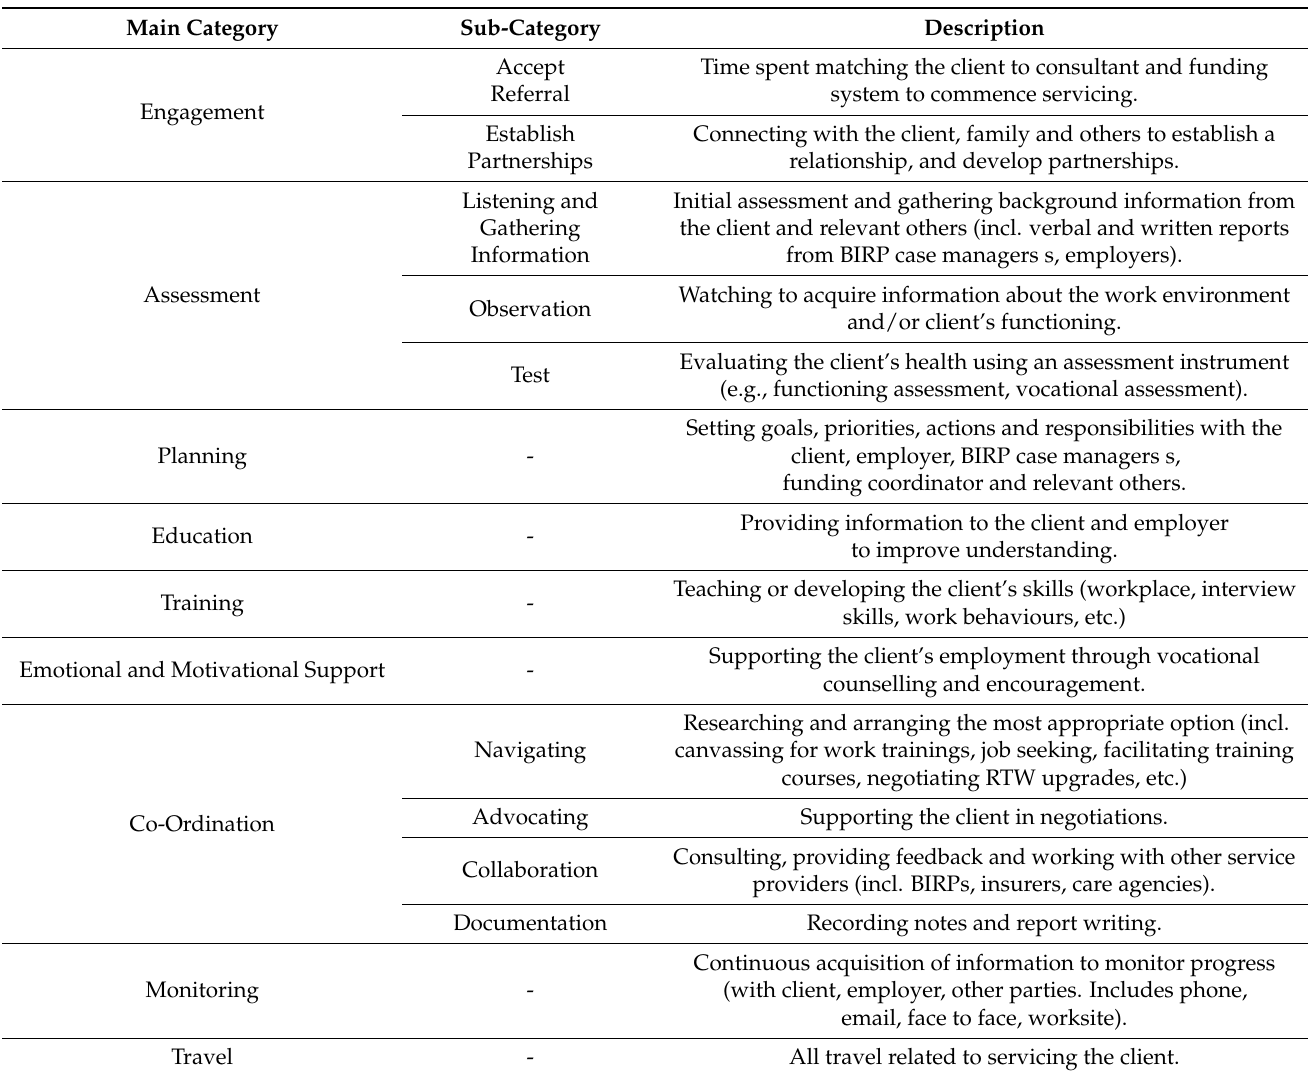
Table 2. CMTaxonomy adapted for Vocational